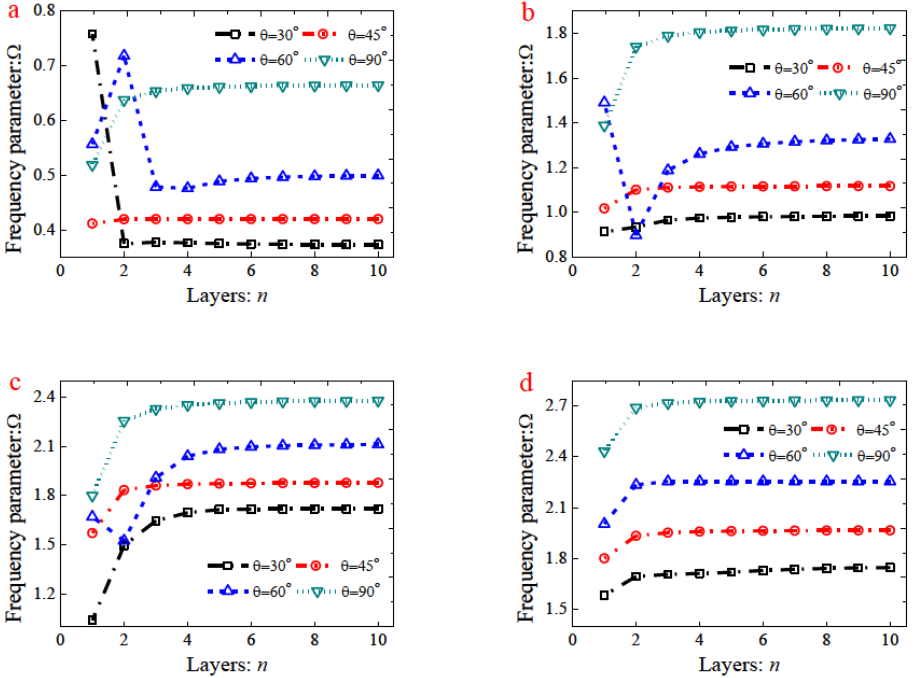
Figure 10: Variation of the frequency parameters Ω number of layers n for a [0 o / θ o ] n layered annular sector plate with FSFS boundary condi- tions: (a) 1st mode; (b) 2nd mode; (c) 3rd mode; and (d) 4th